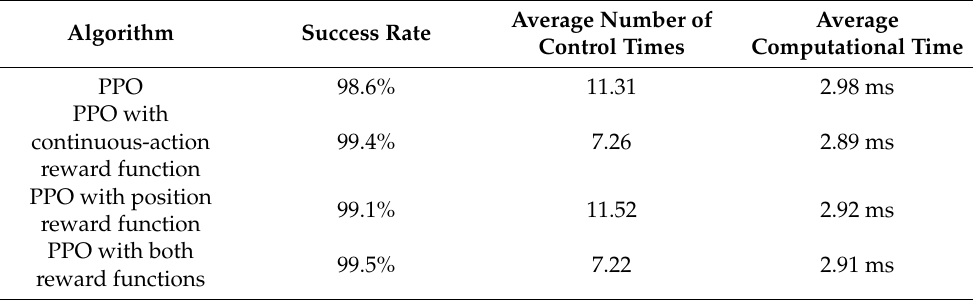
Table 3. Performance of different agents in fixed-position destination